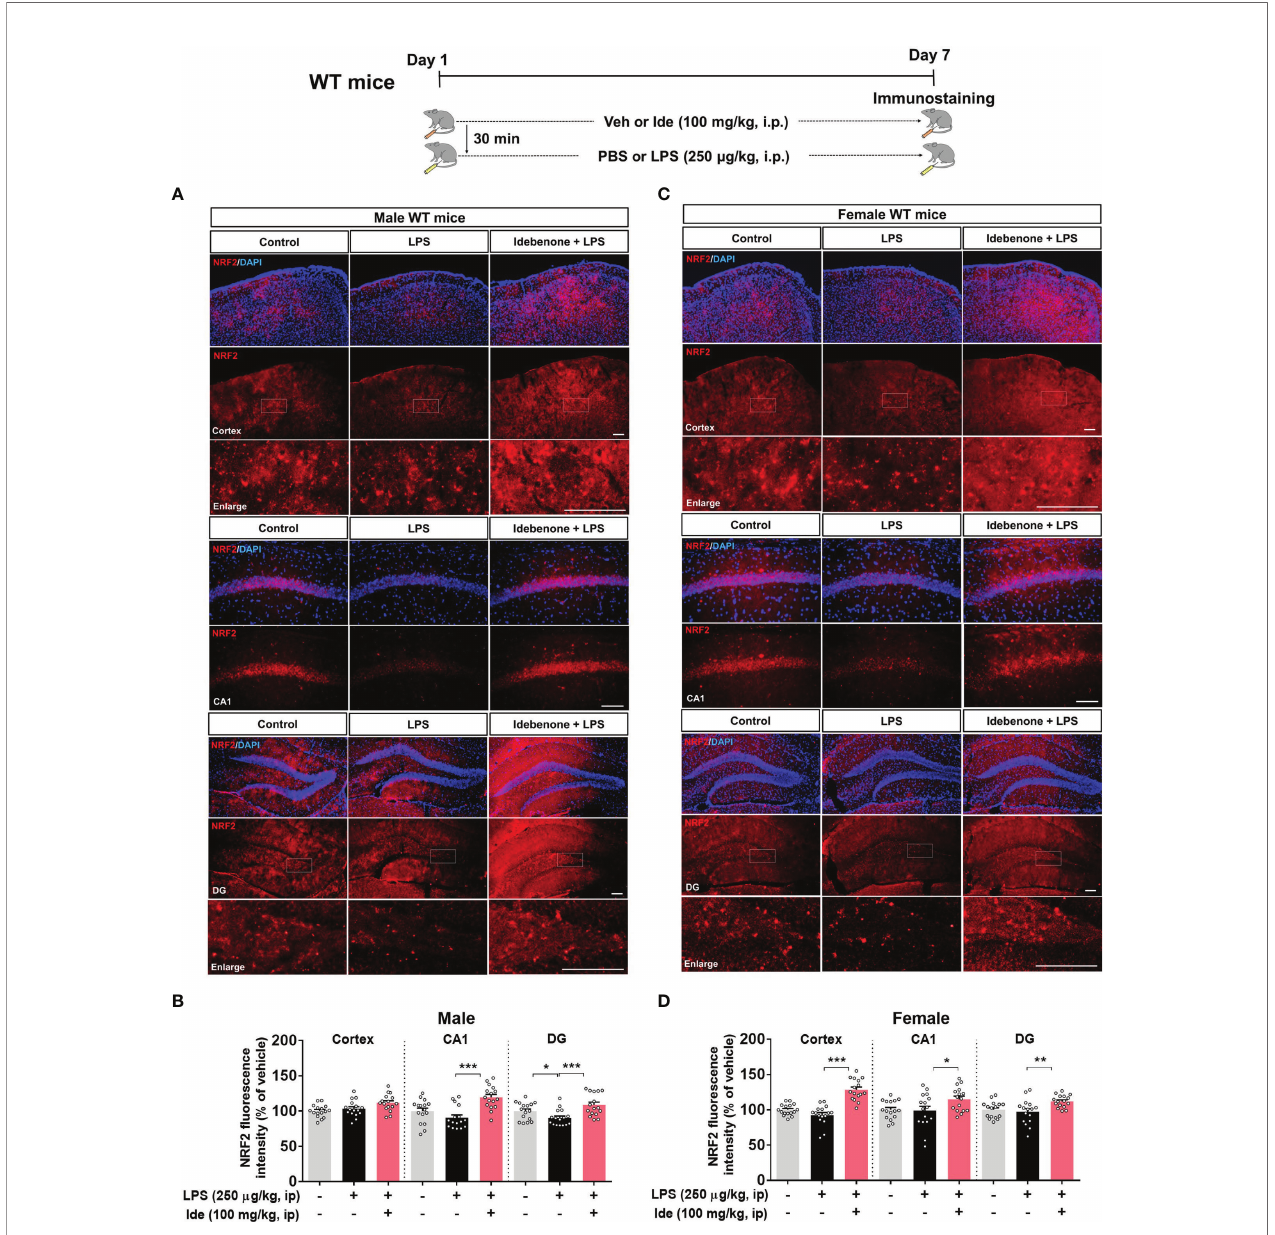
FIGURE 1 | Idebenone upregulates the neuroprotective marker NRF2 in LPS-treated male and female wild-type mice. (A, C) Male and female wild-type mice were administered idebenone (100 mg/kg, i.p.) or vehicle (5% DMSO + 10% PEG + 20% Tween80) followed 30 min later by LPS (250 m g/kg, i.p.) or PBS administration. This regimen was repeated daily for 7 consecutive days, and immuno fl uorescence staining with an anti-NRF2 antibody was conducted. (B, D) Quanti fi cation of the fl uorescence intensity of NRF2 in brain slices from LPS-treated male and female wild-type mice (n = 16 brain slices from 4 mice/group). *p < 0.05, **p < 0.01, and ***p < 0.001. Scale bar = 100 m